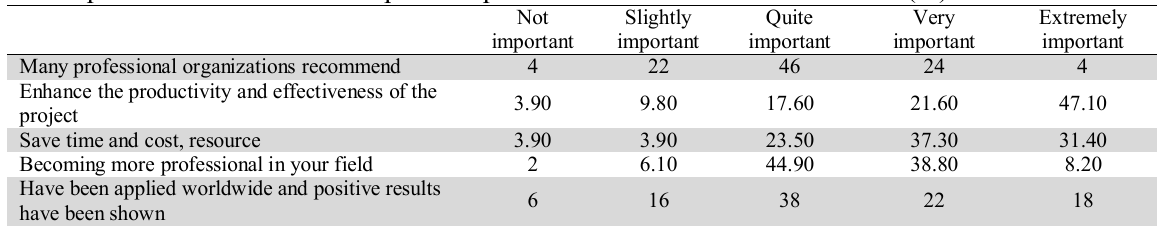
Not Slightly Quite Very Extremely important important important important important 8.20